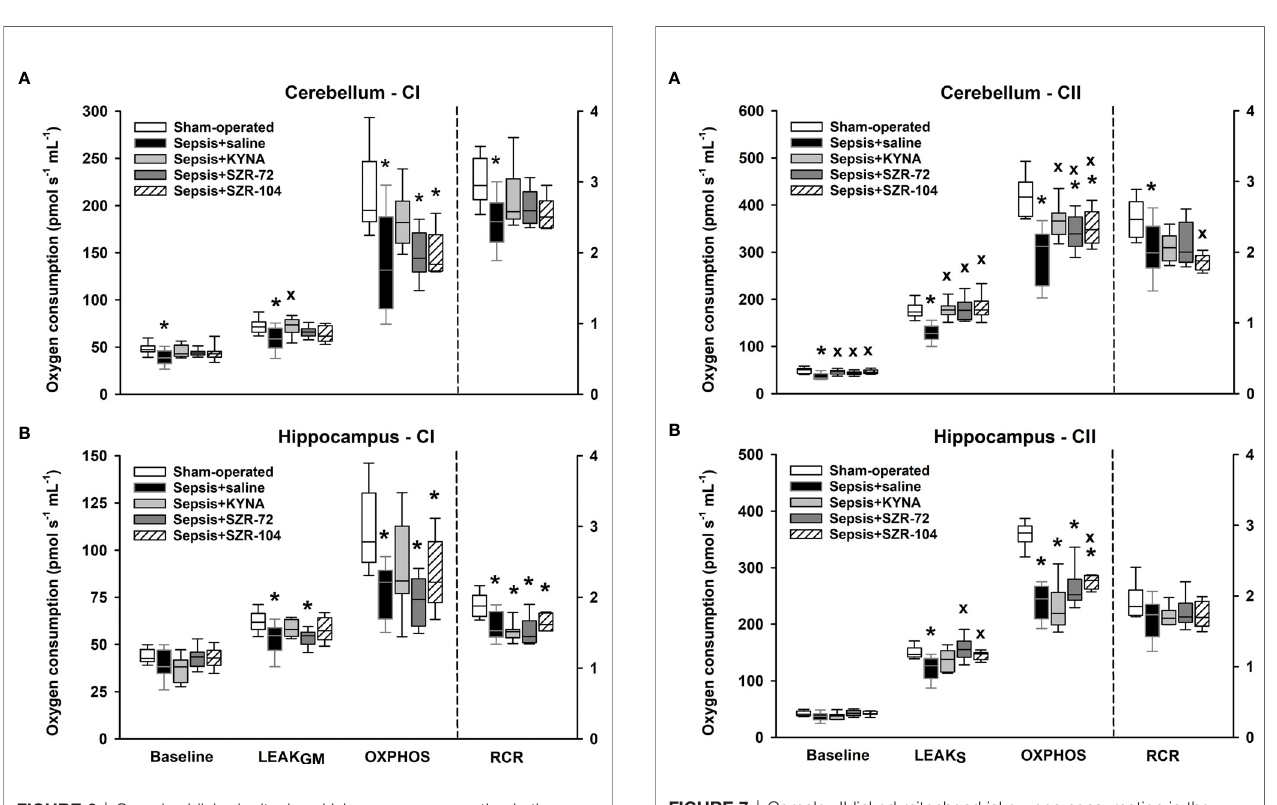
FIGURE 6 | Complex I-linked mitochondrial oxygen consumption in the cerebellum (A) and the hippocampus (B) in the sham-operated group and in the different sepsis groups treated with saline, KYNA, SZR-72 and SZR-104. The plots demonstrate the median (horizontal line in the box) and the 25 th (lower whisker) and 75 th (upper whisker) percentiles. One-way ANOVA, Holm – Sidak post-hoc test; * P < 0.05 vs . sham-operated group; x P < 0.05 vs . sepsis+saline group.